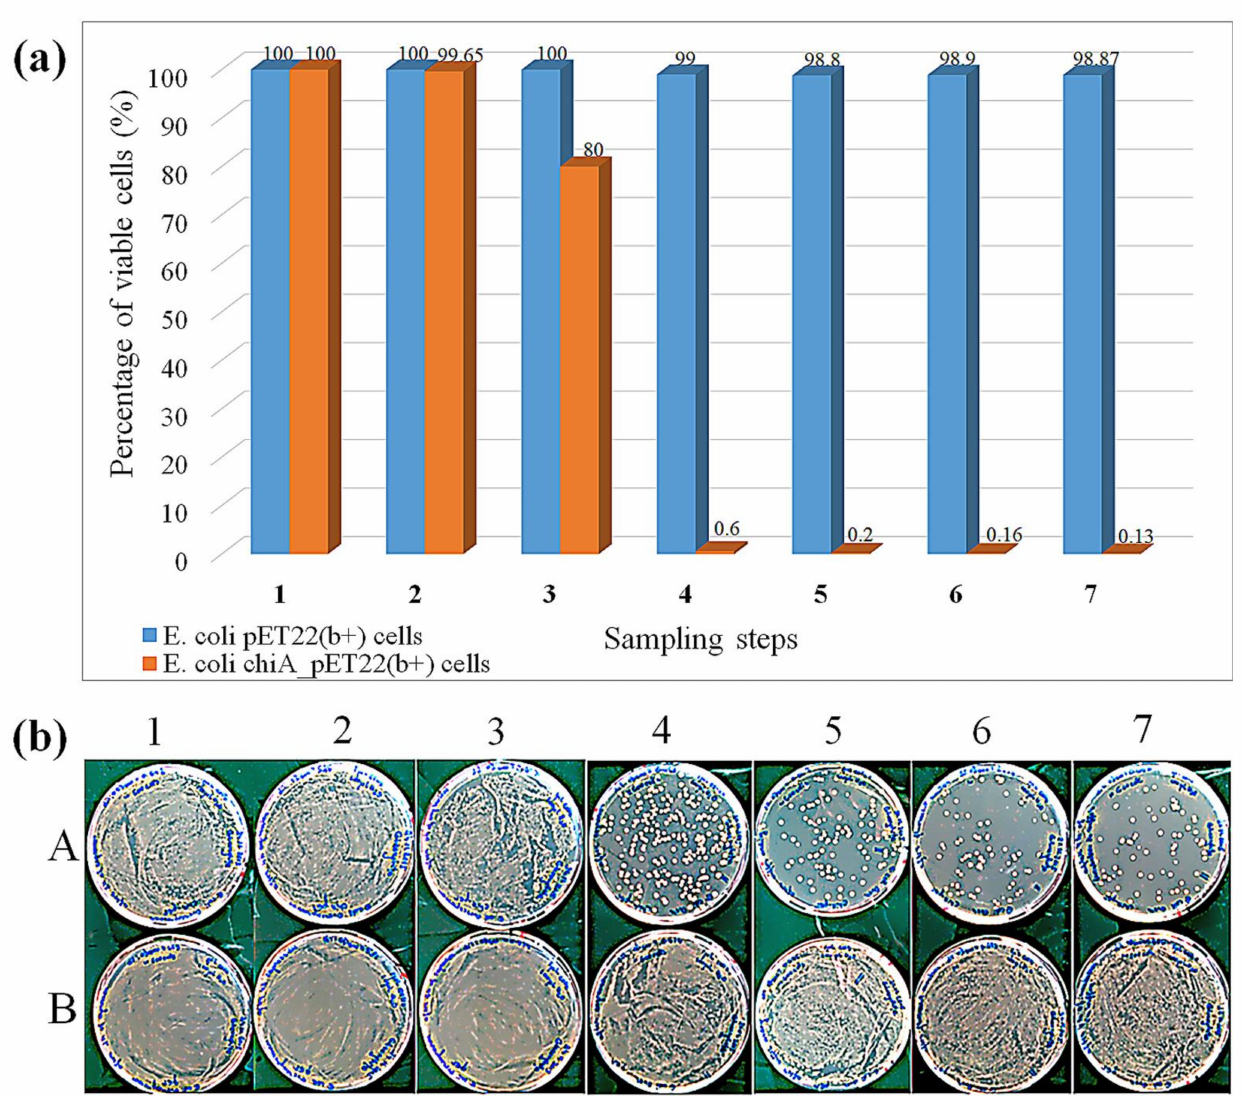
Figure 4. Cell viability assay at different phases of expression, cell washing, and enzymatic reaction. ( a ) Percentage of cell viability. ( b ) Plate assay, corresponding to the quantitative data shown in (a), comparing E. coli BL21 (DE3) cells transformed with chi A_pET22b or the empty pET22b(+) vector. Sampling steps on x -axis: 1 = 2 h expression, 2 = 4 h expression, 3 = 6 h expression, 4 = 18 h expression, 5 = 18 h expression and washing, 6 = 18 h expression, washing, and enzymatic reaction (30 min), 7 = 18 h expression, washing, and enzymatic reaction (4 h). Data are means ± standard errors representing n = 3